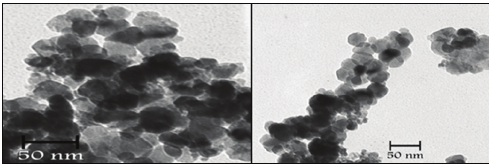
F 3: TEM micrographs of ZnO